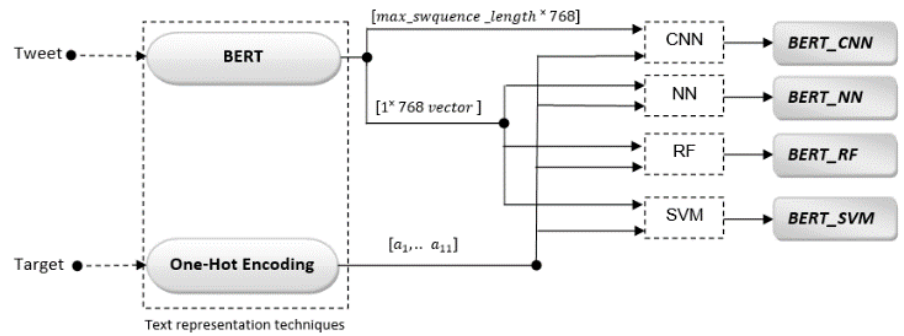
Figure 4. Methodology for designing stance classifiers.